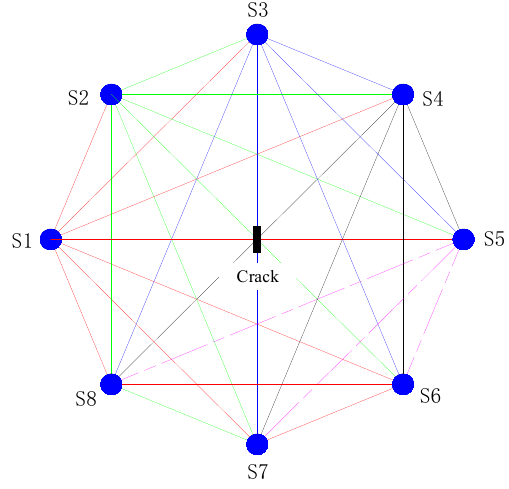
Figure 4. Zero sensor layout with zero angle crack.